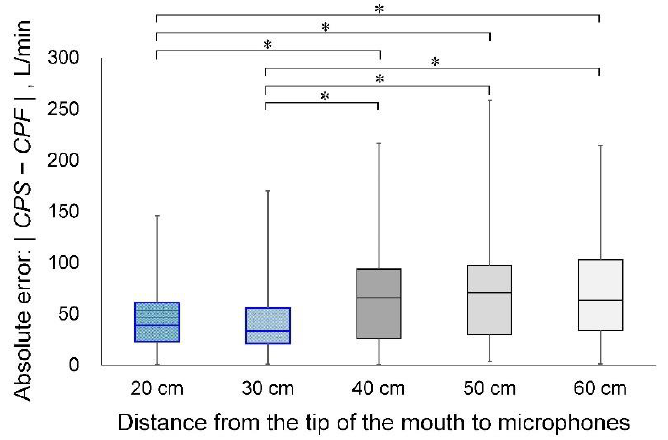
Figure 5. Comparison of the absolute error between each measurement condition. CPF , cough peak flow; CPS , estimated cough peak flow; * p < 0.001.